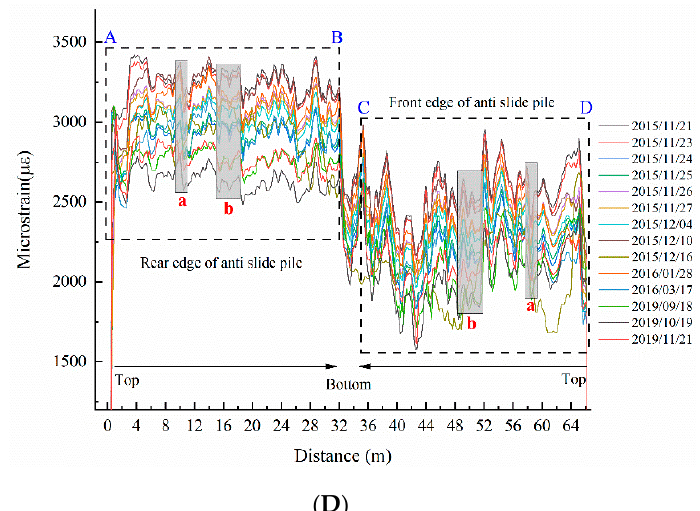
Figure 5. Strain curves diagrams of MS2, MS3, MS5, and MS6 for different periods. ( A ) Strain curves diagram of MS2; ( B ) Strain curves diagram of MS3; ( C ) Strain curves diagram of MS5; ( D ) Strain curves diagram of MS6. (In this figure, a represents optical data of the boundary between earth-yellow clay with gravel and purplish-red gravel with clay. Because the boundary between the loaded section and embedded section of the anti-slide pile is close to the boundary between strong and weak rock formations, b represents these two boundaries optical data and their adjacent optical data. The blue A and B represent the top and bottom of the rear edge of anti-slide pile, respectively; the blue C and D represent the bottom and top of the front edge of anti-slide pile, respectively).